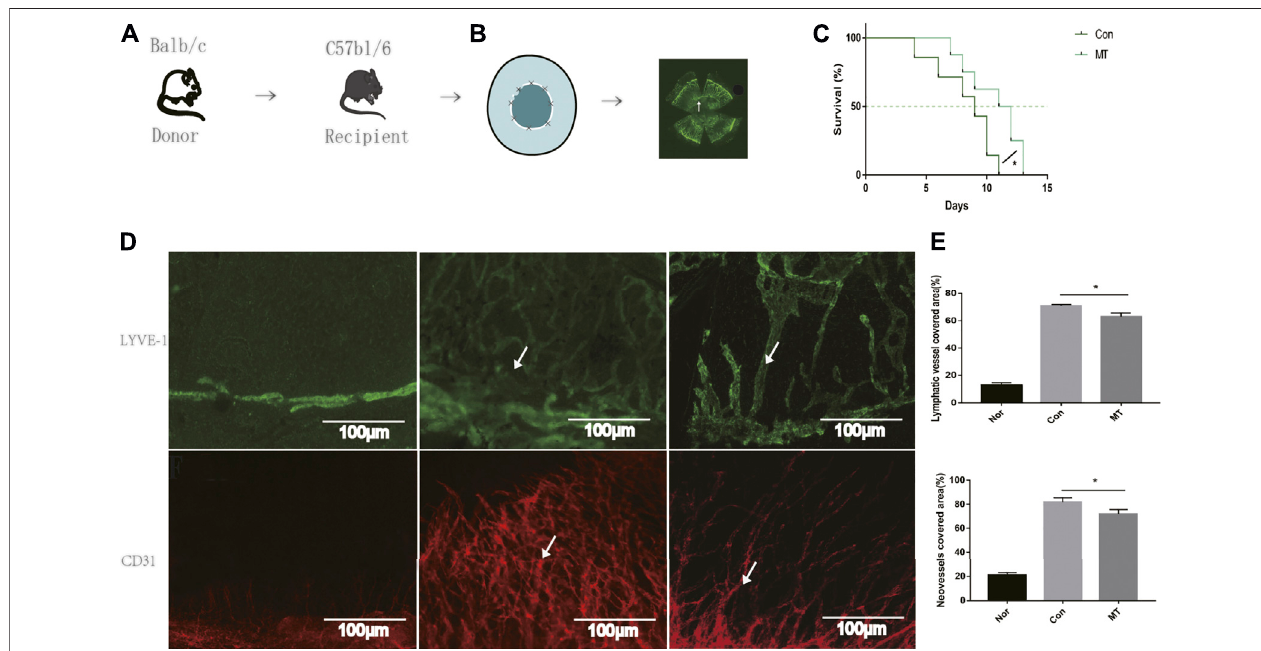
FIGURE1| MTtherapyalleviatescornealgraftrejectionandcorneallymphangiogenesisandangiogenesis. (A) Establishmentofthecornealtransplantationmodel. (B) Combined image of all lymphatic vessels reaching the interface 9 days after corneal transplantation (white arrows). (C) Postoperative corneal graft survival curve of mice(CT;MT:50 mg/kg).MTinjectiondelayedcornealgraftrejectioncomparedtothesalinegroup( n (cid:1) 8pergroup). (D) Onday9oftransplantation,LYVE-1andCD31 + staining (white arrows) were performed on the entire cornea of mice. In the normal mouse eye, lymphatics and neovessles are located only at the margin of the cornea and the corneal lymphangiogenesis and angiogenesis developed after transplantation (Scale: 100 µm). (E) MT inhibited corneal lymphangiogenesis and angiogenesis ( n (cid:1) 3 per group) (Nor: Normal group; Con: control group; MT: treated with MT). * p < 0.05, ** p < 0.01, *** p < 0.001.